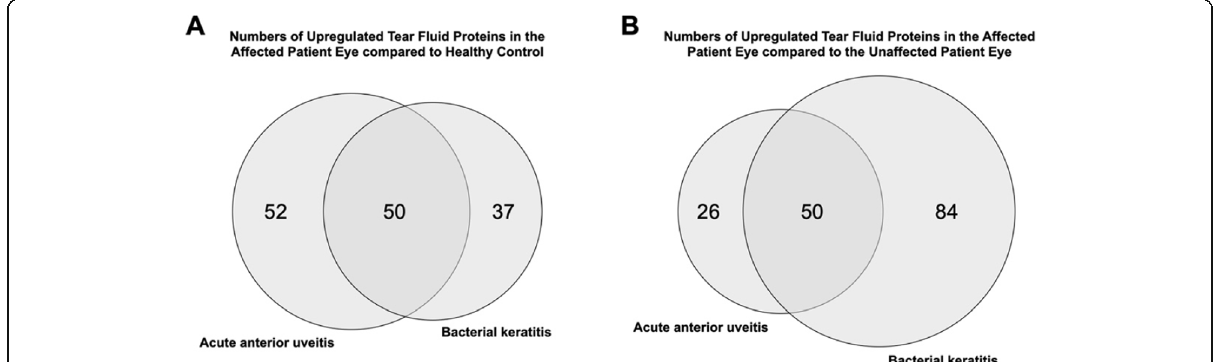
Fig. 1 Venn diagram illustrating the number and degree of overlap for tear fluid proteins that were increased in affected eyes of patient relative to eyes of healthy controls ( A ) or unaffected eyes of patients ( B